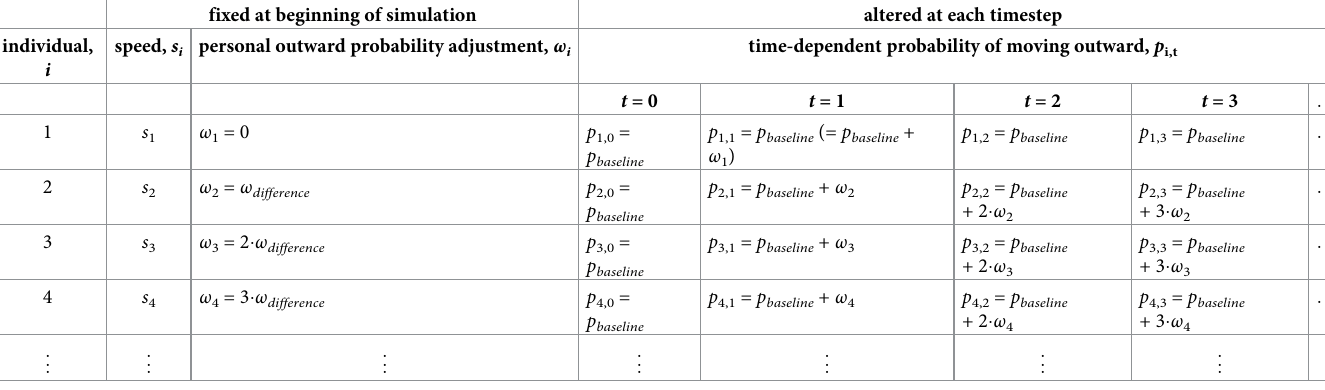
(so at each timestep, each individual becomes more likely to move outward, and the differ- ence between individuals in their values of ω means that outward movement probability i increases faster for bolder individuals, assuming that all individuals have the same knowledge of the foraging site). The individual then makes its movement decision: if it is at the foraging site ( d � d ), it does not move (so d = d ); if the refuge site lies between itself and the i , t -1 food i , t i , t -1 foraging site (so d < 0, which computationally could occur at the beginning of a simulation i , t -1 due to small floating-point errors in the calculation), it moves towards to foraging site such that d = d + s ; whereas if it is positioned between the refuge and foraging site (0 � d i , t i , t -1 i ), it draws a random value from a uniform distribution U (0,1). If this random value is d food Table 1. Changes in an individual’s variables over the course of a simulation. fixed at beginning of simulation altered at each